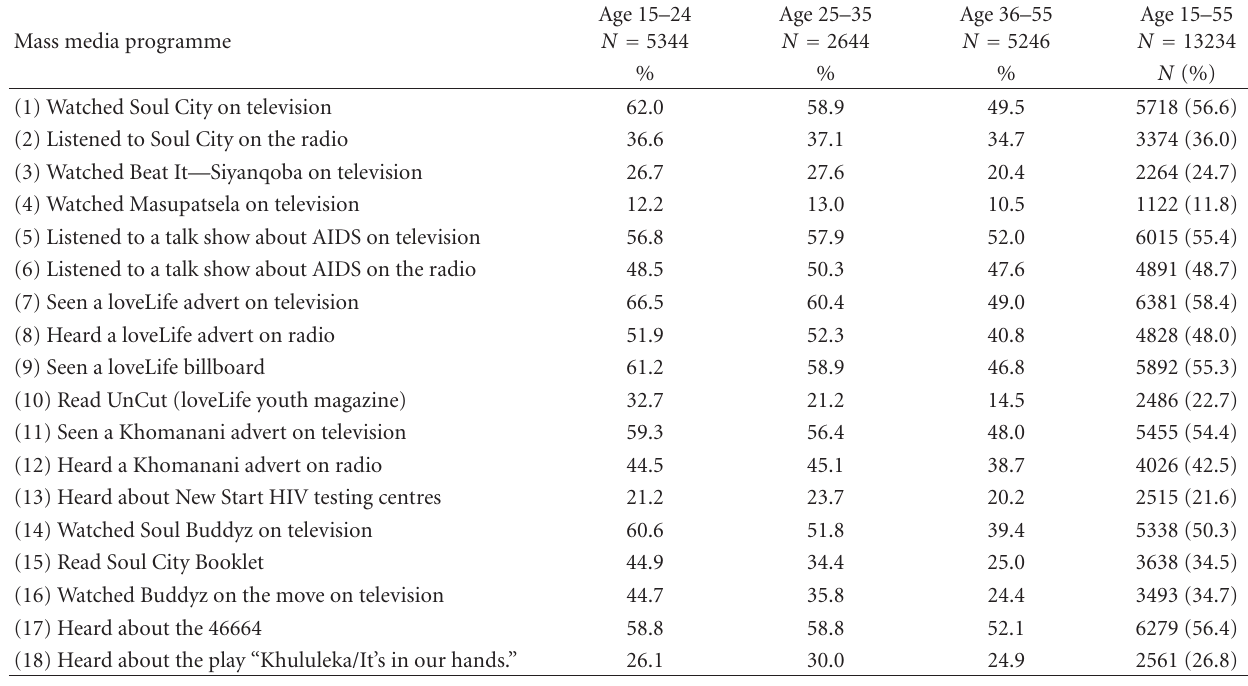
Table 2: HIV mass media communication exposure in the past 12 months by age group expressed as percentages.